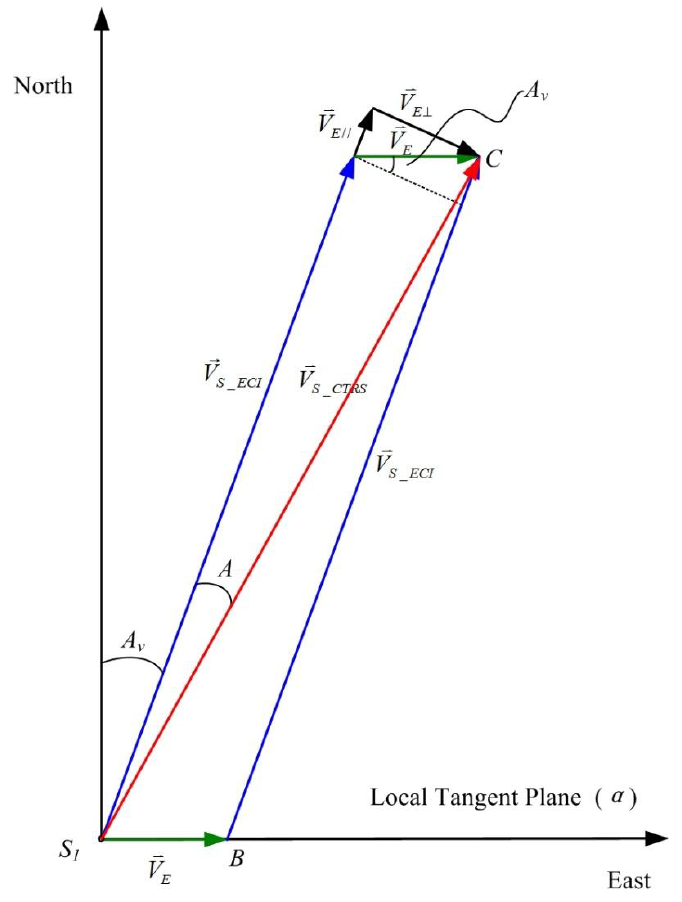
Figure 4. Trigonometry relationship of drift angle A in a local tangent plane at S ISS orientation angle, the projected ISS velocity on the ground at S S_ECI not rotating, the linear velocity due to the Earth self-rotation, and E projected along and cross the ISS flying direction, respectively. E ISS velocity on the ground accounting for the Earth